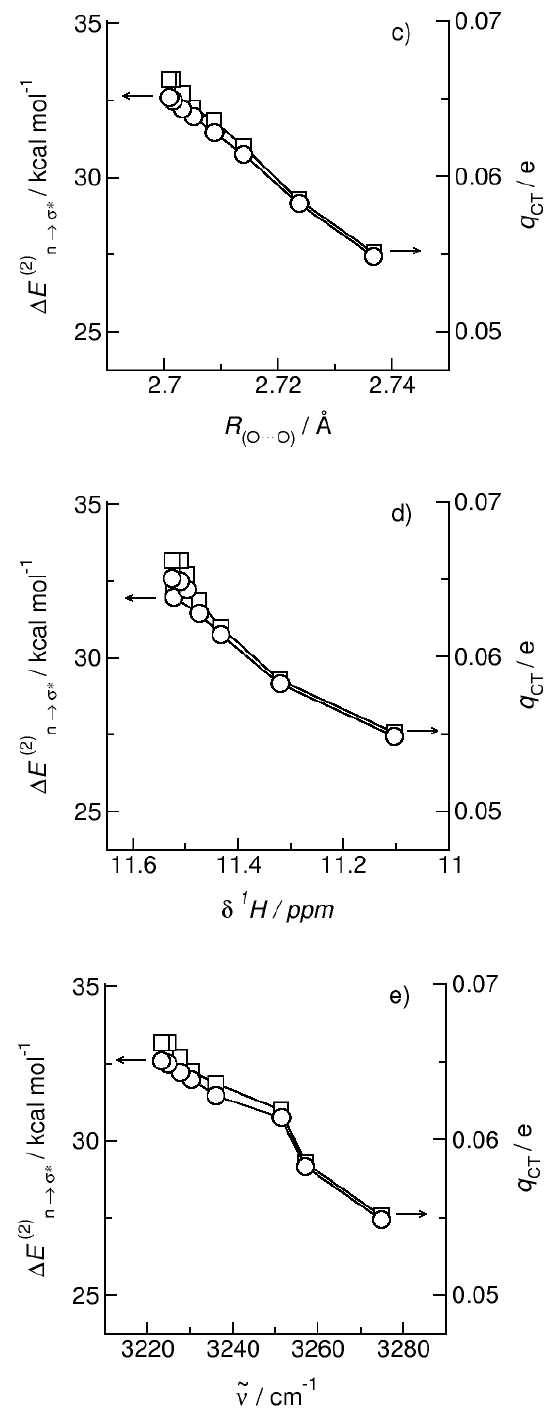
Figure 11. NBO-calculated second-order stabilization energies ∆ E (2) n → σ * (open circles) and estimated total charge transfers q CT (closed squares) for cationic dimers n = 1–8 plotted versus calculated ( a ) energies ∆ E , ( b ) intermolecular hydrogen bond distances, R (H ··· O), ( c ) intermolecular hydrogen bond R (O ··· O), ( d ) NMR proton chemical shifts, δ 1 H (relative to the standard tetramethylsilane, TMS), and ( e ) OH vibrational frequencies (cid:101) ν (OH). The almost linear dependences showing slight odd/even effects indicate the strong relation between NBO stabilization energies and charge transfers with energetic, geometric, and spectroscopic properties of the cationic dimers.